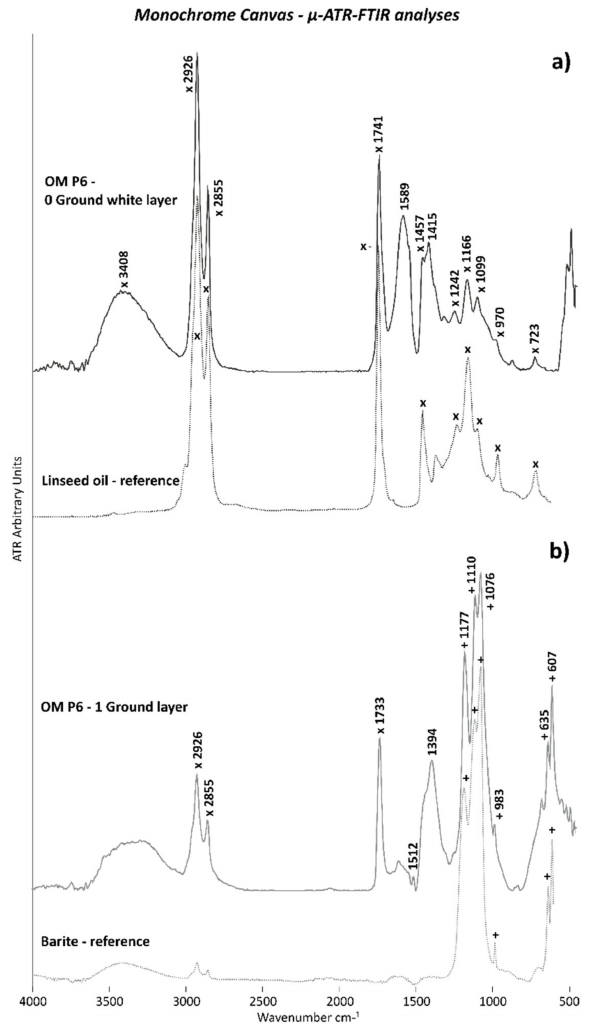
Figure 5. ATR spectra of white ground layers ( a ) 0 and ( b ) 1 of OM P6. The ATR spectra of the linseed oil (x) and barite (BaSO 4 ) (+) references are also